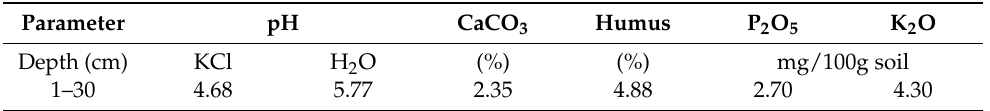
Table 2. Chemical composition of Cambisol Dystric